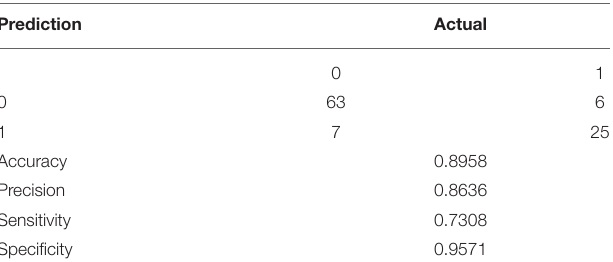
TABLE 3 | Confusion matrix and evaluation indicators of model 2 on the testing set. Prediction